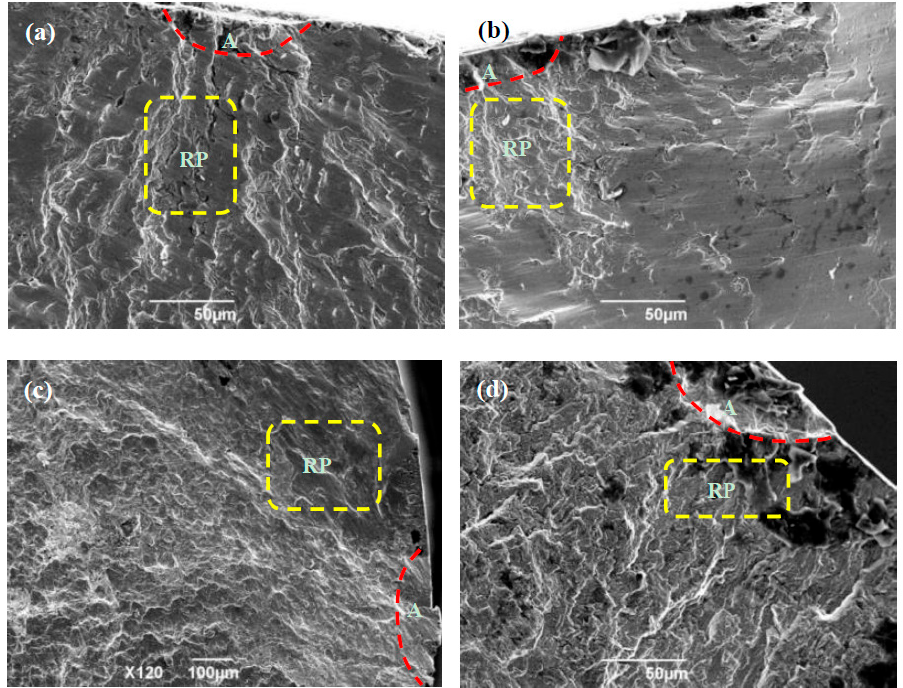
Figure 7. Fracture morphologies of fatigue crack initiation region under proportional tension–torsion loading at different stress amplitudes. ( a ) S eq = 560.5 MPa, ( b ) S eq = 611.5 MPa, ( c ) S eq = 713.3 MPa, ( d ) S eq = 763 MPa. ‘A’ represents fatigue initiation zone and ‘RP’ represents river pattern.